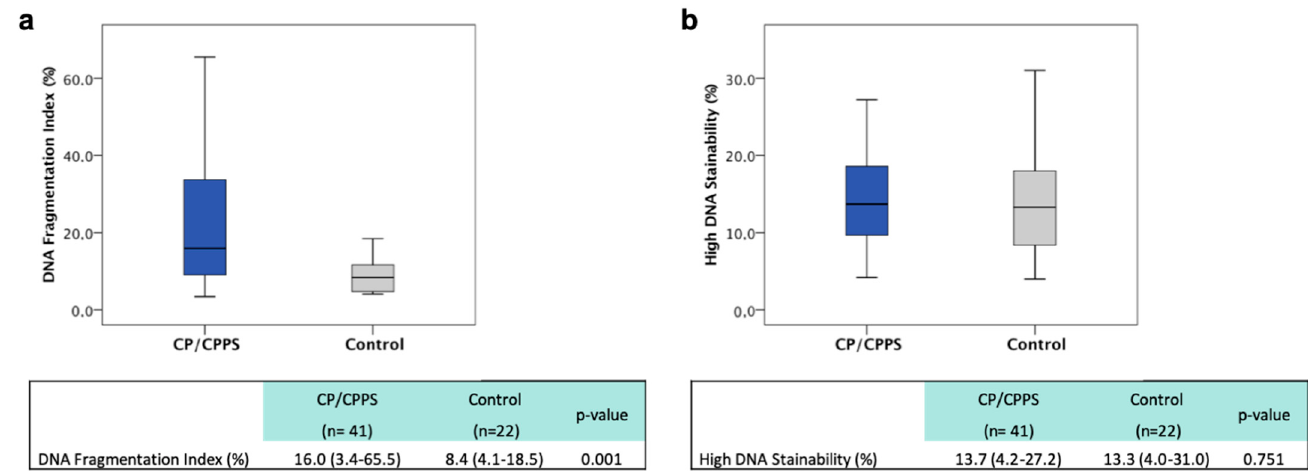
Figure 1. DFI CP/CPPS patients vs. control ( a ); HDS CP/CPPS patients vs. control ( b ).